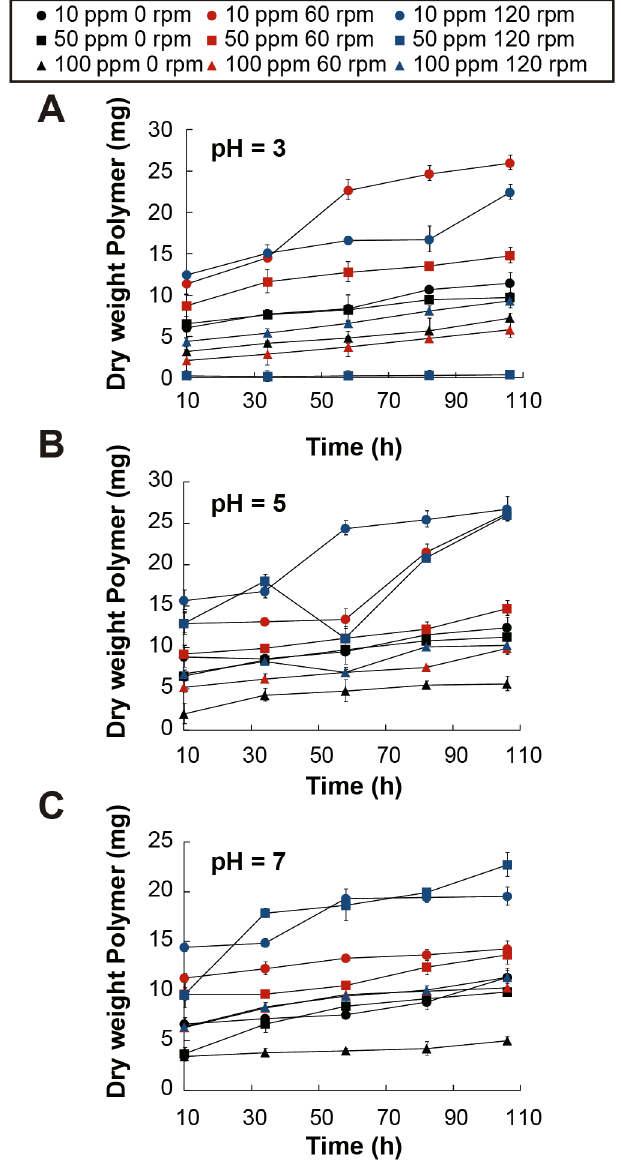
Fig 7. Effect of Agitation Speed, pH and Metal Concentration on Exopolysaccharide Production in Rhodotorula mucilaginosa strain UANL-001L. Dry weight exopolysaccharide obtained at different time points when grown at low, medium and high levels of Rpm and metal concentration and keeping pH constant at A) 3, B) 5 and C)